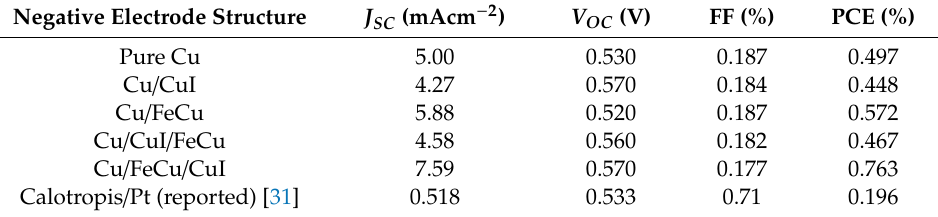
Figure 8. ( a ) Band diagram of various DSSC components and ( b ) J-V characteristic curves for all electrode combinations. Table 2. Performance characteristics of DSSC constructed using all negative electrode structures. Negative Electrode